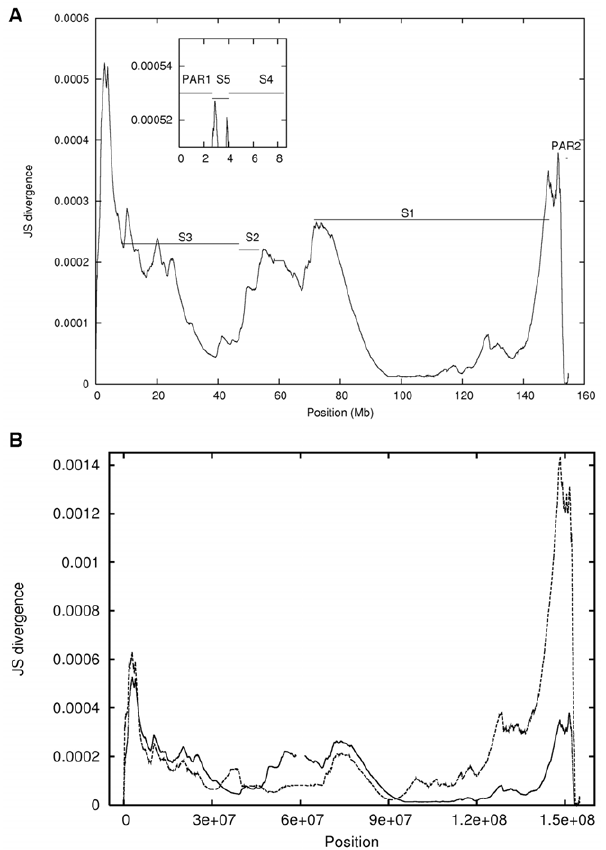
Figure 2. JS divergence as a function of segmentation position for (A) the unmasked X chromosome. The inset is a blow-up of the plot within the region of the highest (JS divergence) peak. (B) When the sequence is masked for repeats the overall shape of the JS divergence plot remains the same except for a change in the order of prominent peaks.